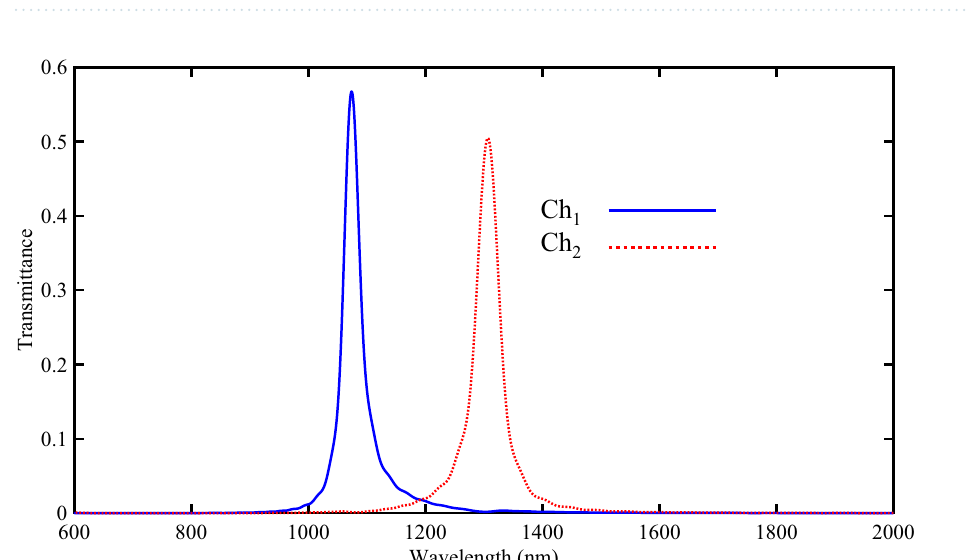
Figure 7. Transmission spectra of the proposed two-channel DEMUX. Also, the field profiles of Hz magnitude for two output channels of the proposed DEMUX are shown in Fig. 8. It should be noted that in Fig. 8a the resonance wavelength of 1074 nm is coupled to the upper RR (RR without the silver NRDs). Also, Fig. 8b shows that the resonance wavelength of 1307 nm appears in the lower RR (RR with the silver